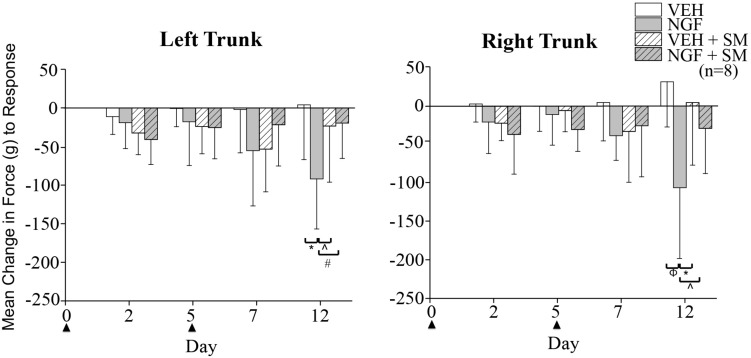
Trunk mechanical hyperalgesia. Mean change from baseline of magnitude of mechanical trunk stimulus required to elicit a pain response (escape, withdraw behavior) following left VEH (50 μl; phosphate-buffer solution/PBS) or NGF (50 μl, 0.8 μM) injections (▲) and daily spinal mobilization (10 min; ∼0.9N). Female rats developed bilateral mechanical hyperalgesia that was prevented by daily spinal mobilization. Statistical analyses were performed by ANOVA followed by Tukey’s test at each time point and data are presented as mean ± SD (*P = 0.006, ∧P = 0.04, #P = 0.03, Φ
P = 0.001).